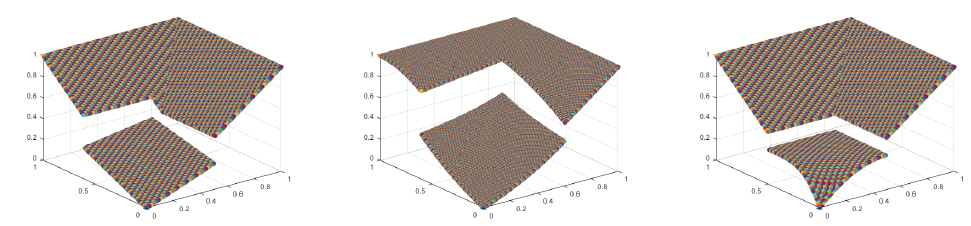
Figure 3. Pseudo-quasi group functions PQG